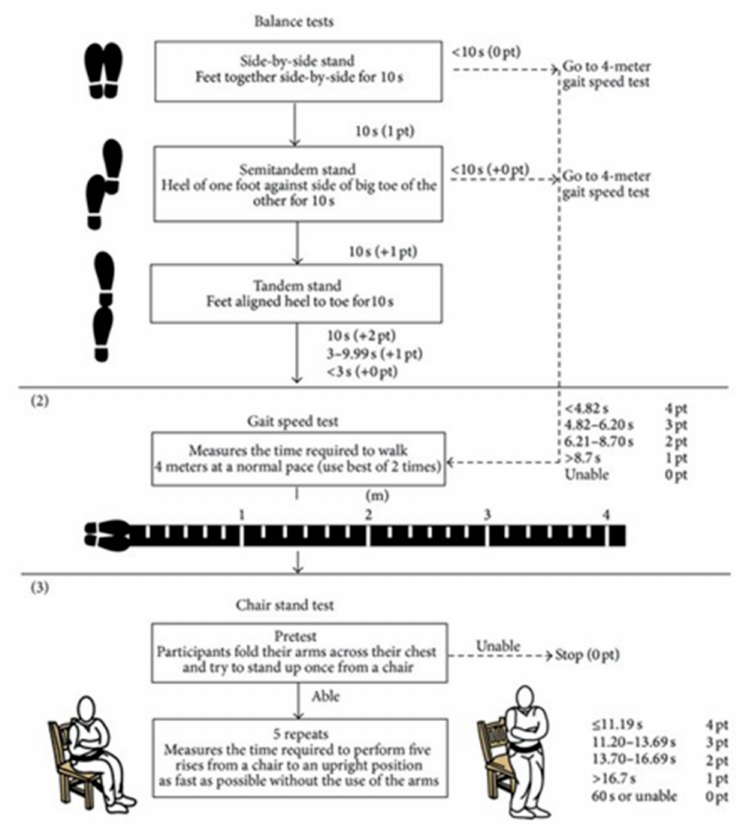
Figure 2. Short performance physical battery test (SPPB) based on Riskowski JL et al. Quality of